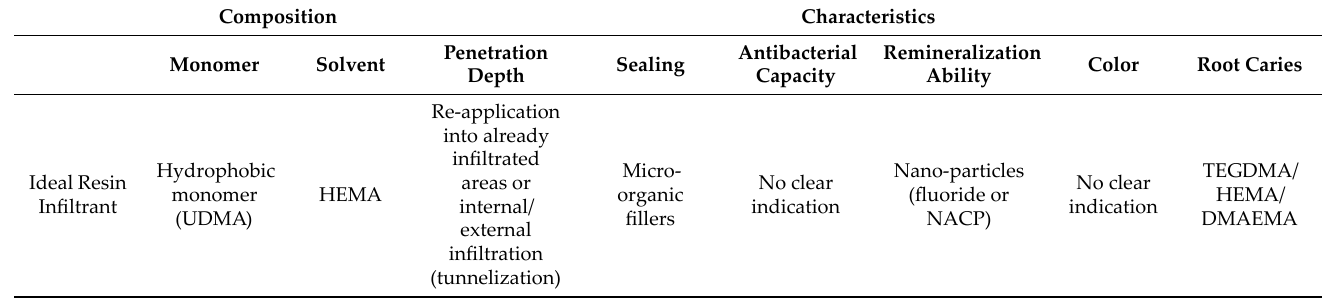
Table 2. Template summarizing an ideal resin infiltrant material according to the information found in the literature regarding formulations and techniques. This literature review helped unfold limits and possibilities of the experimental formulations. It was not possible to extrapolate clear indication regarding the best materials to increase the antibacterial capacity and color stability of a potential novel resin infiltrant due to a variety of molecules tested with no clear standardization of formula‑ tions and setup of the